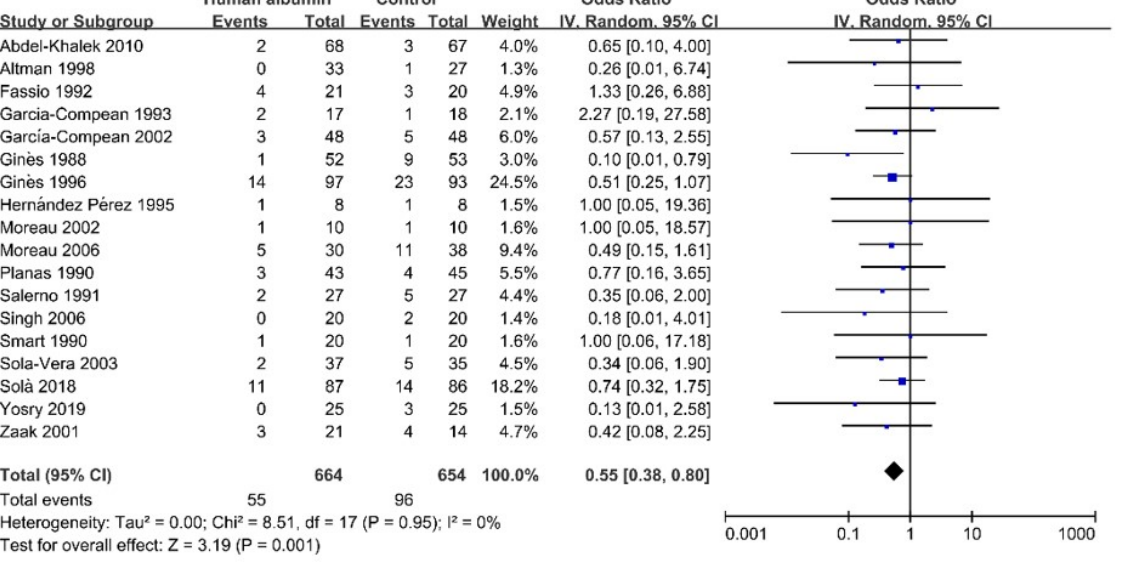
Figure 3. Forrest plots showing the effect of human albumin infusion on the development of hyponatremia in liver cirrhosis without hyponatremia.